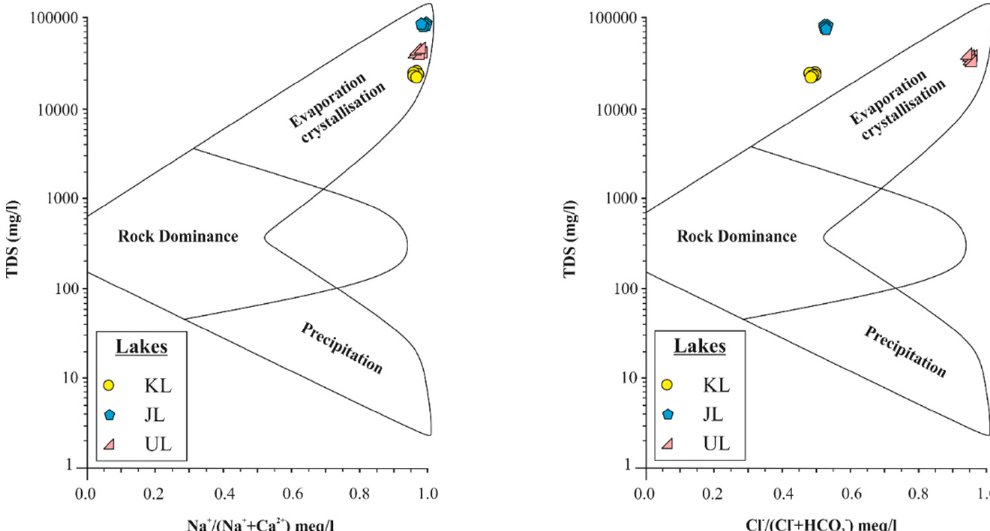
Figure 5. Identification of the mechanisms controlling the lakes’ water chemistry.